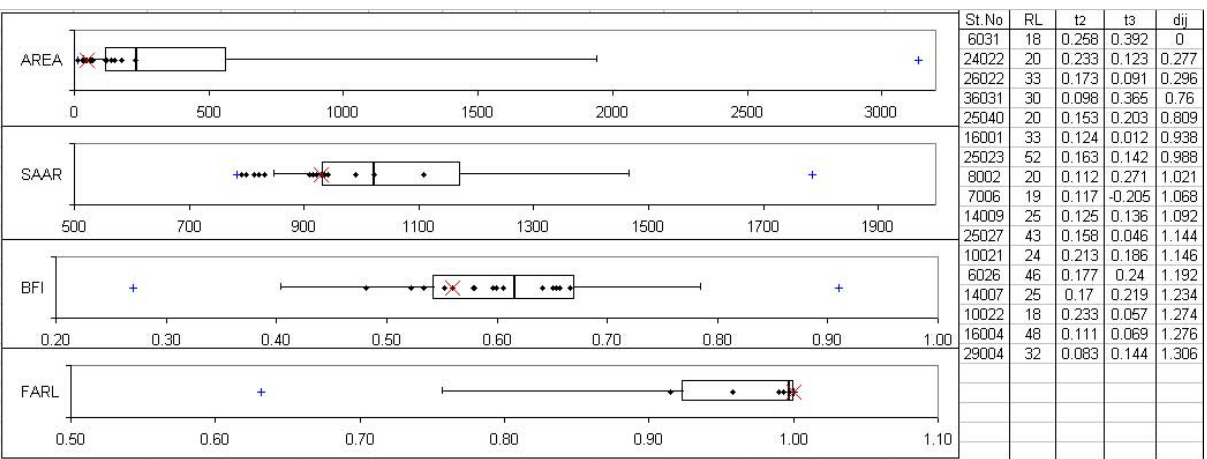
Fig. 9. Four Box-plots and a summary table for investigating a pooling group. The subject site is marked with a × . Small dots denote sites included in the pooling group. The underlying distribution of each catchment descriptor is shown in the Box-plots. Each Box-plot gives the minimum and the maximum value (+) and percentiles for the frequencies 0.05, 0.25, 0.5, 0.75, 0.95. The summary table lists record length,